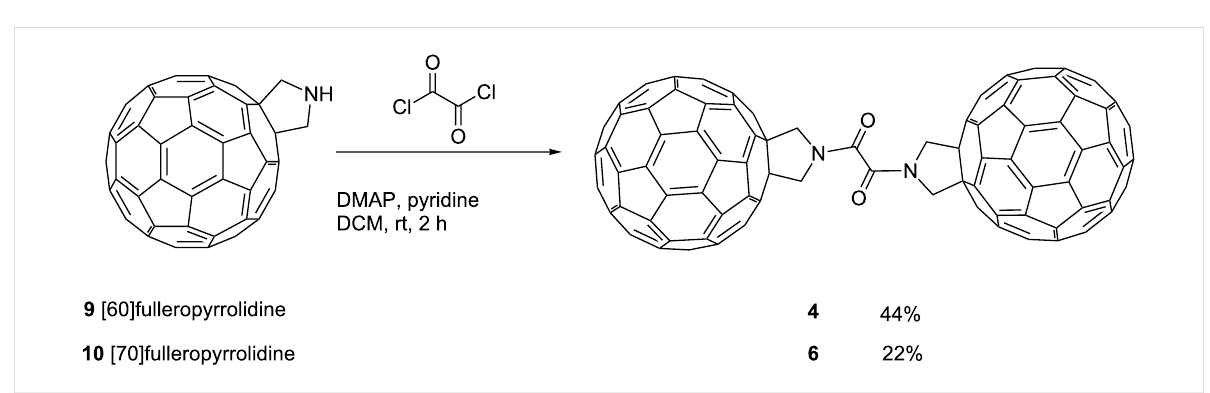
Scheme 1: The one-step synthetic procedure towards the oxalate-bridged fullerene triads 4 and 6 .